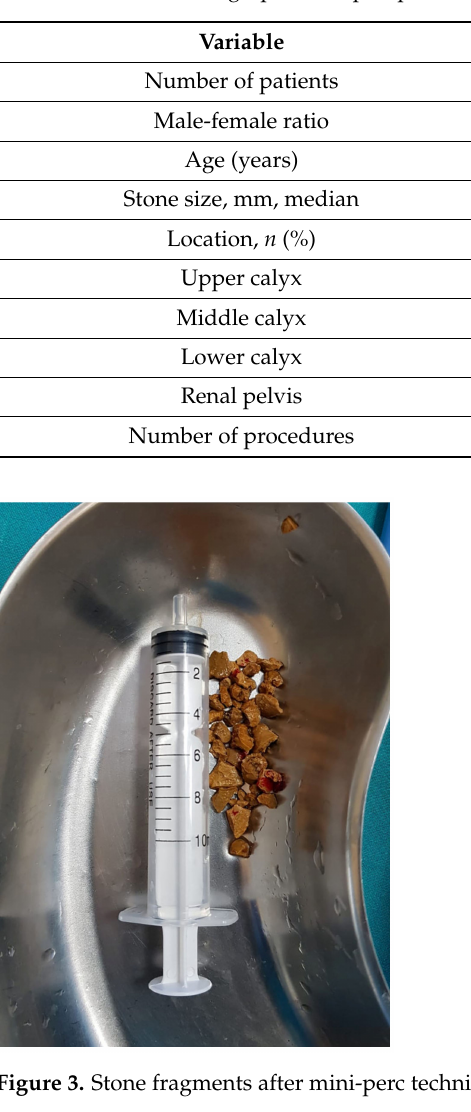
Table 1. Patients’ demographic and preoperative data.